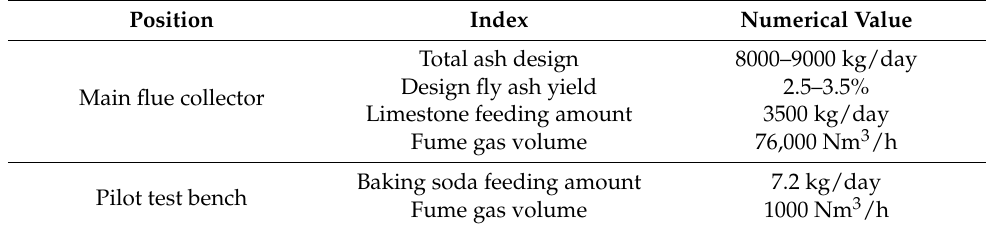
Table 3. Data on fly ash yield calculation of light main flue and pilot